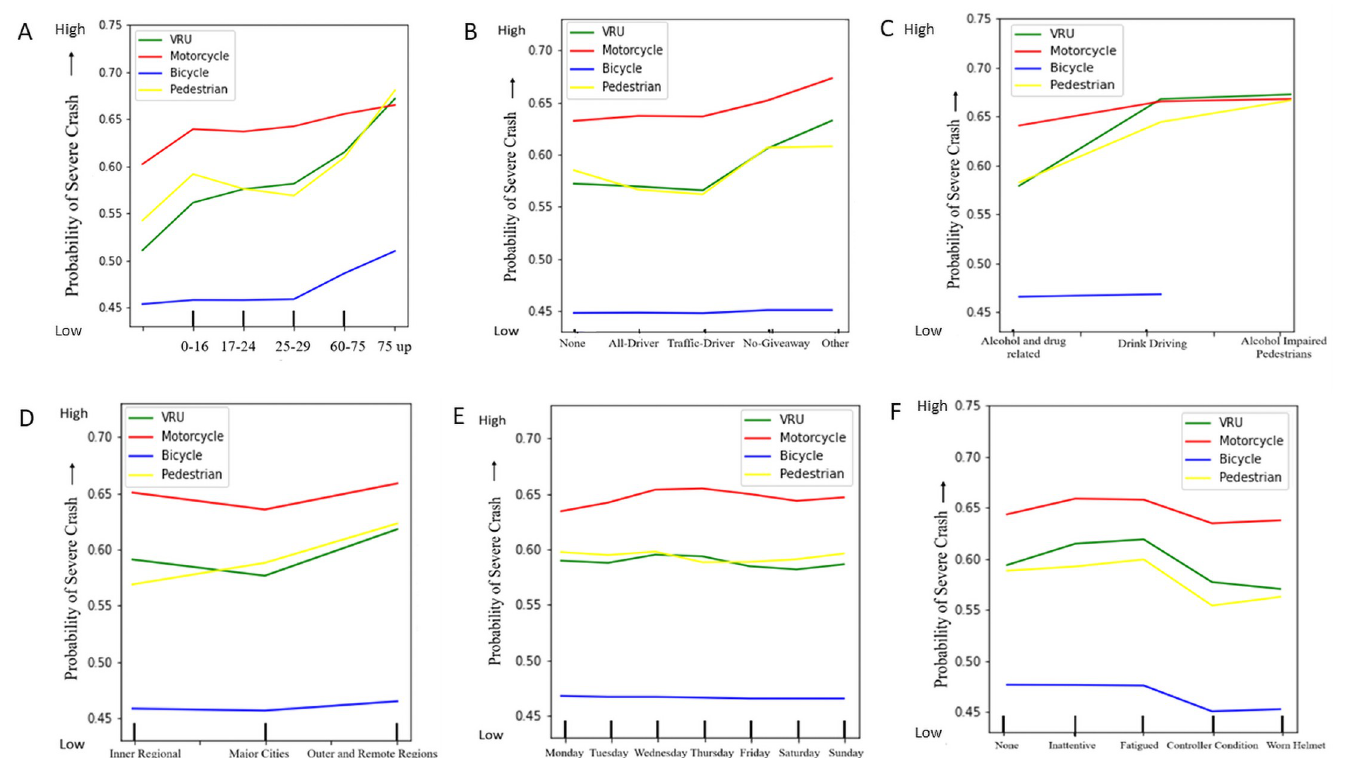
Fig 5. Partial dependency plots of different features with respect to VRU crash severity. (A) Age Group (B) Disobey Road Rule (C) Drink, Drug and Alcohol Related (D) Area Remoteness (E) Day of Week (F) Driver Condition.